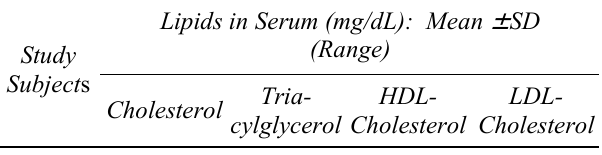
Table 2: Serum lipid profiles in the controls and arsenicosis patients Lipids in Serum (mg/dL): Mean ± SD (Range)